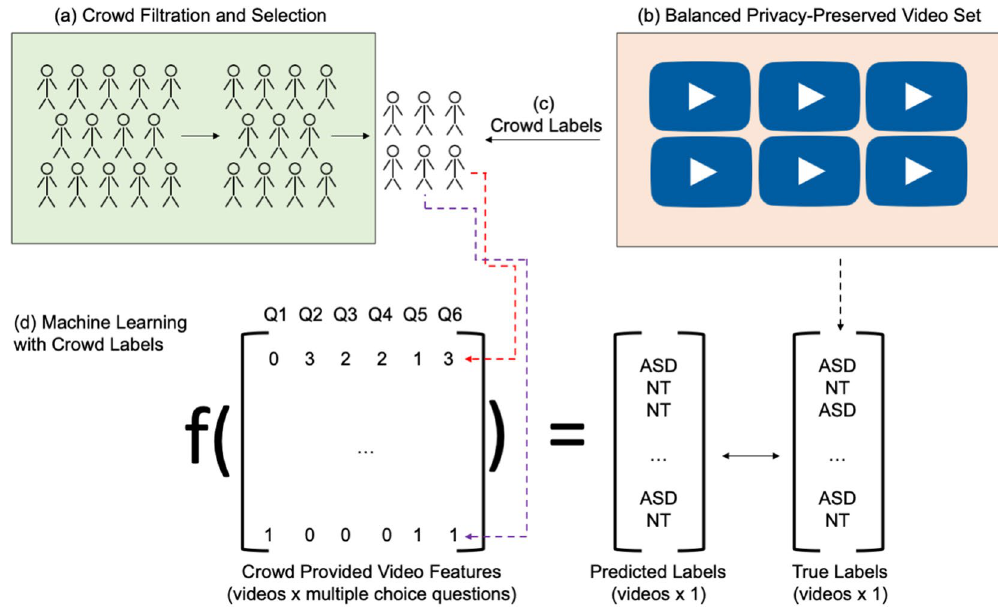
Figure 1. Overview of the crowd-powered AI detection process. ( a ) A trustworthy crowd is selected through a filtration process involving an evaluation set of videos. ( b ) A diagnosis and gender balanced set of unstructured videos are evaluated both with and without a set of privacy-preserving alterations: pitch shift and face obfuscation. ( c ) The curated crowd extracts behavioral features about the children in the videos by answering a set of multiple choice questions about the child’s behavior exhibited in the video, with each worker assigned to a random subset of the videos. ( d ) A classifier trained on electronic medical records (the “training set”) corresponding to the multiple choice answers to behavioral questions is used to predict the diagnosis from the aggregated video-wide annotations (the “test set”), and the classifications are compared against the known diagnoses in the video set (the “test